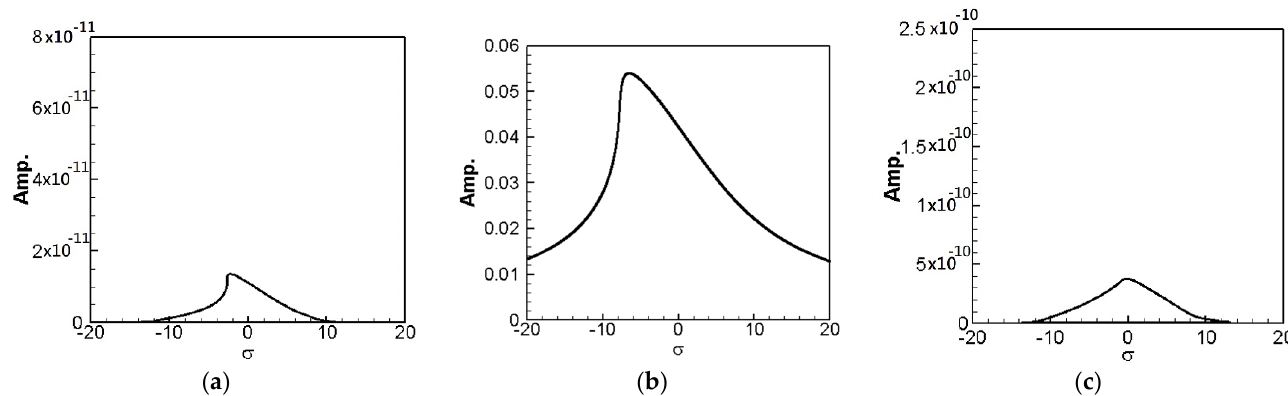
Figure 5. SES system fixed points plots of the 2nd mode being excited. ( a ) 1st mode response, ( b ) 2nd mode response, and ( c ) 3rd mode response.